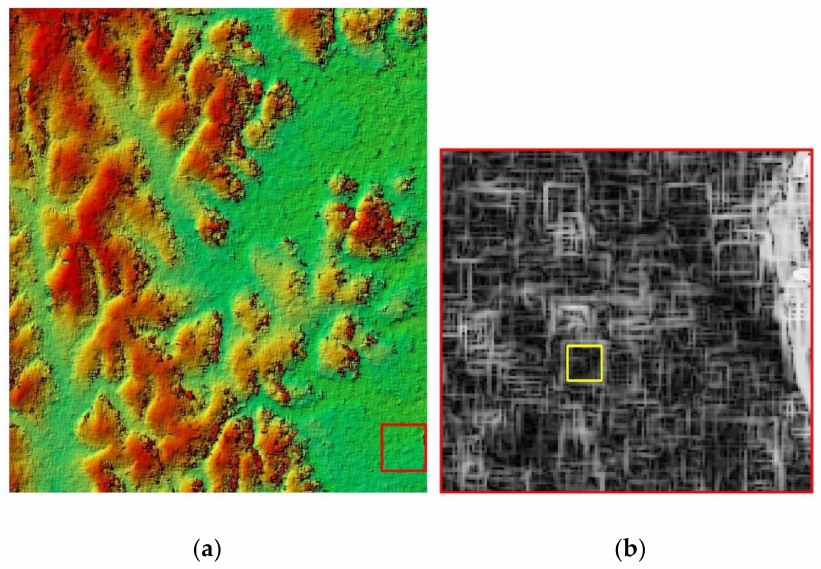
Figure 15. Combined hypsometry-hillshade representation of the P-band DTM ( a ) and a hypsometric representation of slope in a small flat area (yellow square represents the artifact-free area in which the slope errors are calculated in Section 3.1.1) ( b